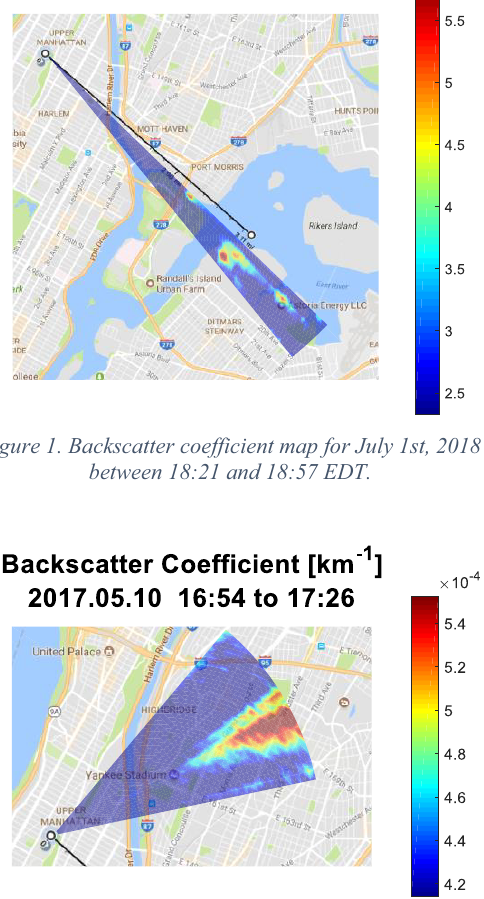
Figure 2. Backscatter coefficient map for May 10th, 2017 between 16:54 and 17:26